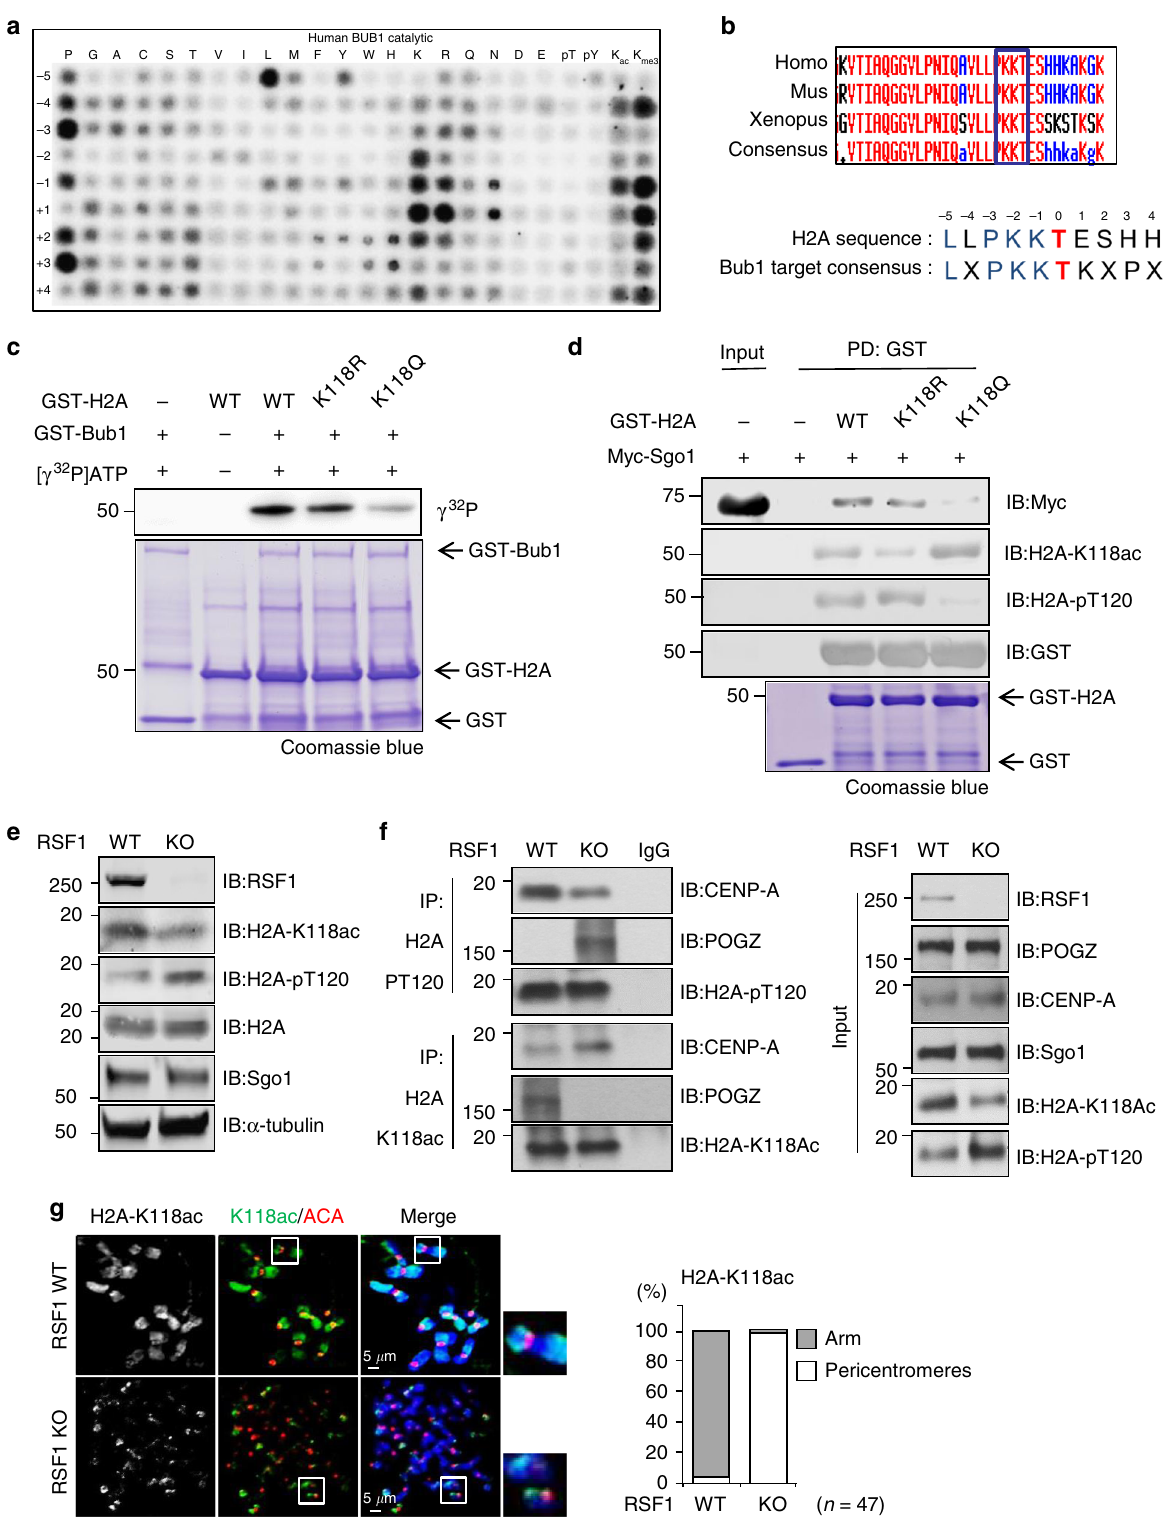
analyzed by immunoblotting for analysis of histone modi fi cations and interactions. As expected, H2A-K118Q displayed a strong H2A-K118 acetylation with a weak H2A-T120 phosphorylation. And Sgo1 binding to the H2A-K118Q was also substantially reduced (Fig. 2d). We veri fi ed that immobilized H2A histone variants were tightly associated with other histones such as